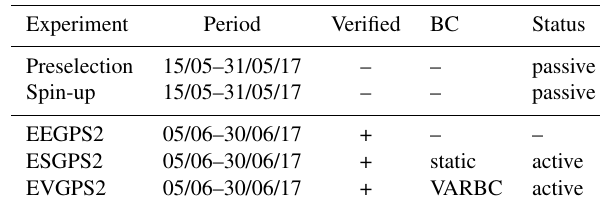
Table 1. Summary of the observing system experiment with the data assimilation system of AROME/Hungary and the use of GNSS ZTDs. Dates are in dd/mm/yy